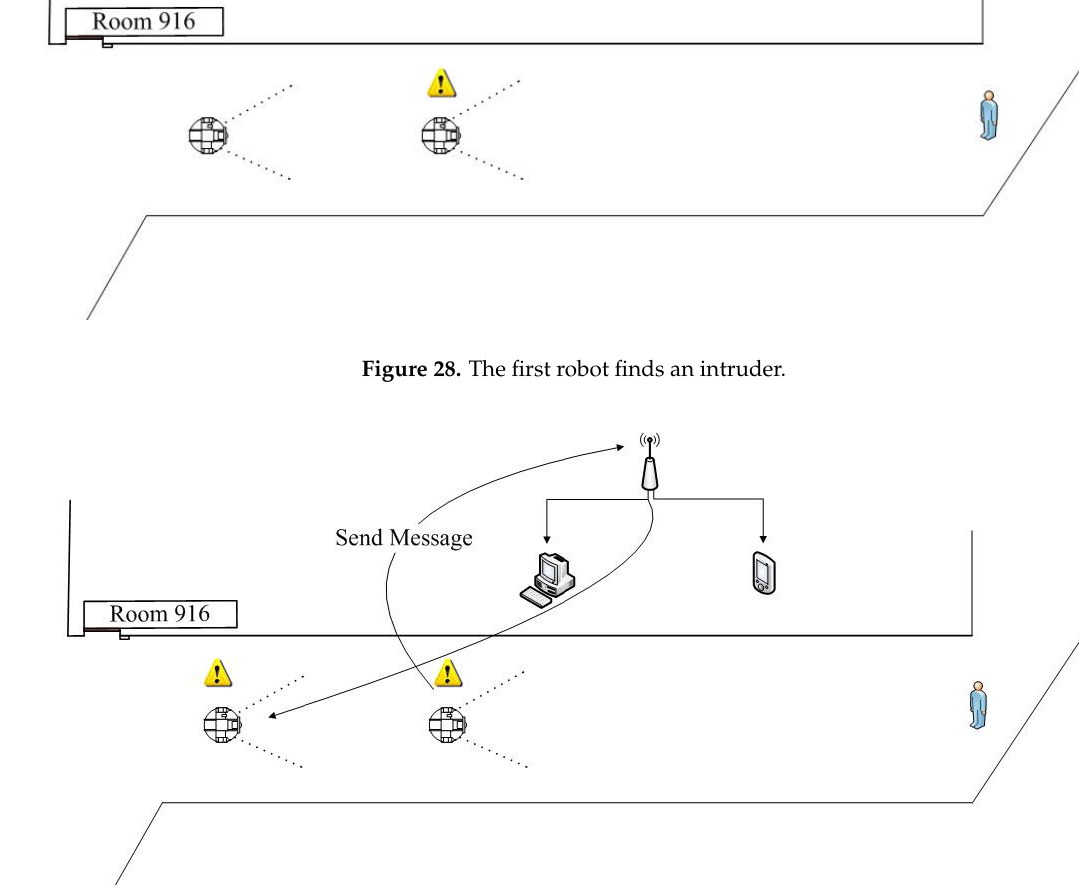
Figure 29. The first robot sends an alarm message to the remote control center and to the second robot.